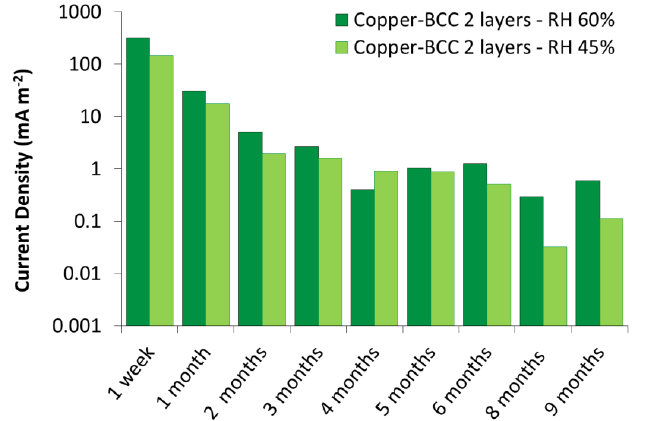
Figure 11. Average macrocouple current density detected at constant temperature (25 °C) and relative humidity (60% and 45%) for galvanic sensors with copper substrate and double layer of BCC artificial patina.